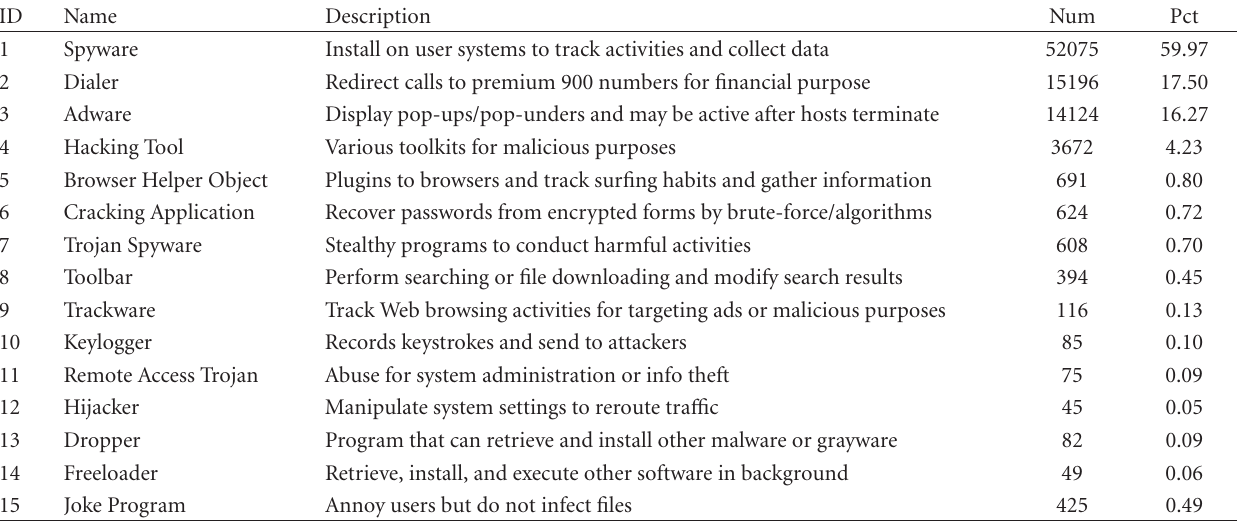
Table 2: Categories of species in the Trend Micro grayware